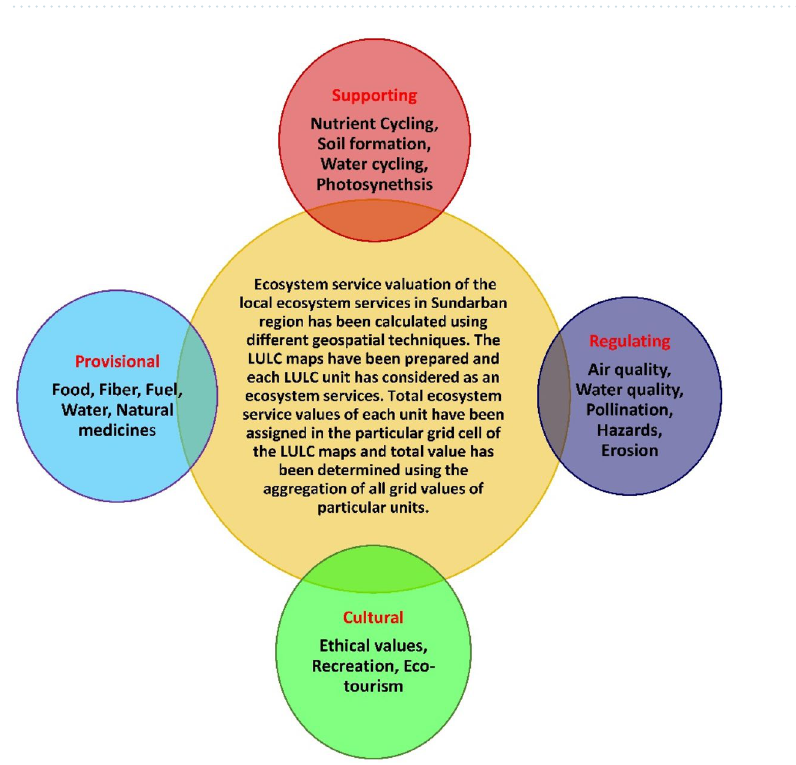
Figure 3. Graphical structure of the various ecosystem